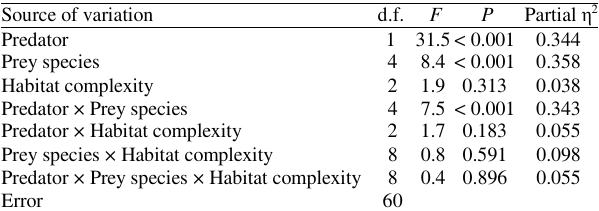
(Table 1): the two-way and three-way interactions with habitat complexity were all non-significant, indicating that the effect of habitat complexity on prey survival to P. corruscans piscivory was similar for all the prey species. Predator, prey species and predator × prey species interaction were the most important sources of variation ( (cid:2) 2 , Table 1), the two latter mostly due to the low vulnerability of I. punctatus to P. corruscans piscivory